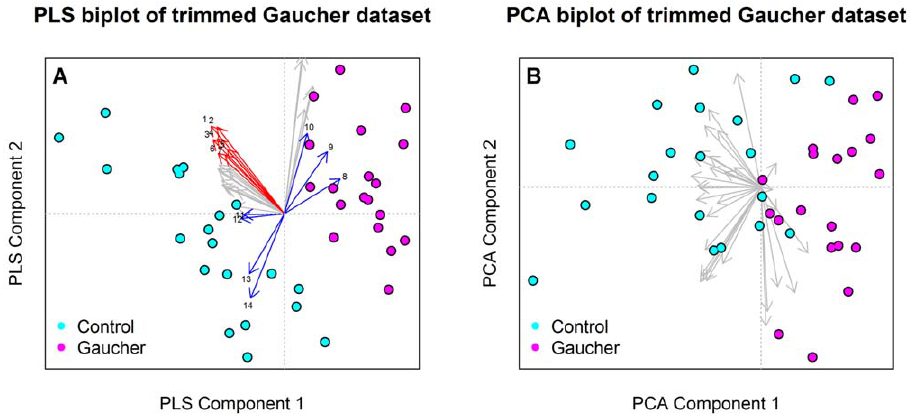
Figure 4. Comparison of PLS and PCA for dimension reduction. These plots demonstrate the capacity PLS has to separate classes based on the top 30 variables ( Figure 4A ) in the Gaucher dataset when compared to PCA (Note that this class separation is being heavily influenced by the loadings highlighted in Blue. Additionally, the vectors highlighted in red explain the within class variation in the control group. This is a key advantage PLS has over other methods.